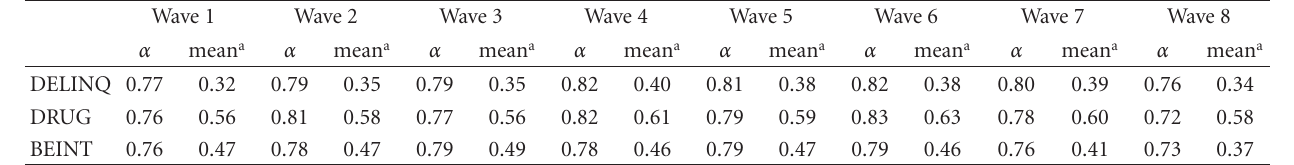
Table 2: Internal consistency and mean inter-item correlations for composite problem behavior